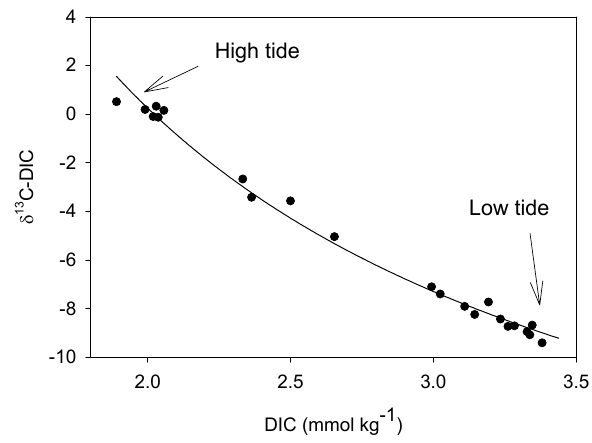
Fig. 7. Correlation between dissolved inorganic carbon concentra- tions and its stable isotope composition for samples collected during a diurnal cycle. Full line represents a fitted first order polynomial, of the form y = y 0 + a/x , with y 0 = − 22.4 ± 0.4.